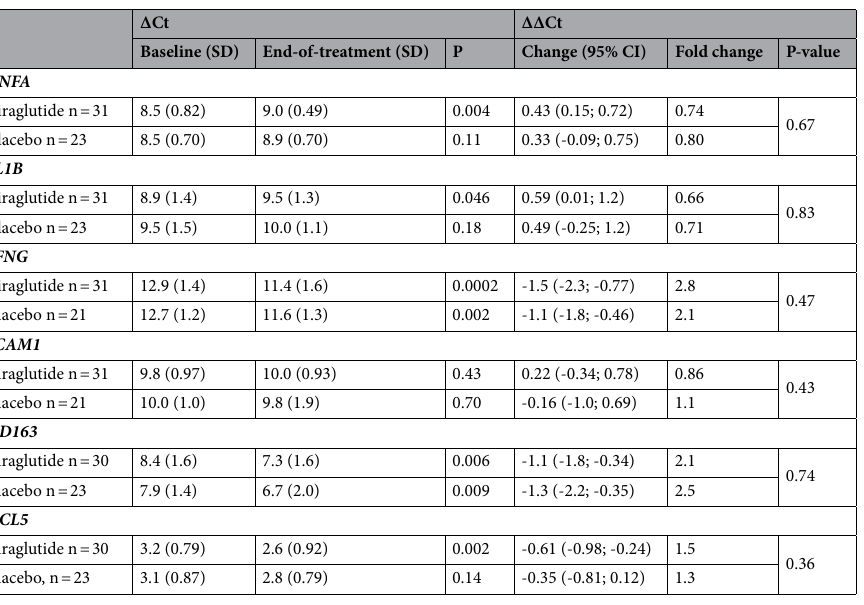
Table 2. Changes in expression of selected inflammatory genes in PBMCs from 54 patients with T2D randomized to liraglutide vs placebo treatment. Gene expression of selected inflammatory genes before and after 26-weeks of treatment with liraglutide vs placebo measured by quantitative real-time PCR. Ct cycle threshold. ∆Ct = Ct (gene of interest) – Ct ( ACTB) . ∆∆Ct = ∆Ct (baseline) − ∆Ct (end-of-treatment). A positive ∆∆Ct is interpreted as an upregulation of the gene, a negative ∆∆Ct is interpreted as a downregulation of the gene. Fold change = 2 −∆∆Ct . Data are mean (SD) or change (95% CI). Paired t-test for comparisons between baseline and end-of-treatment within groups and unpaired t-test for comparison of the change from baseline to end-of-treatment between the two